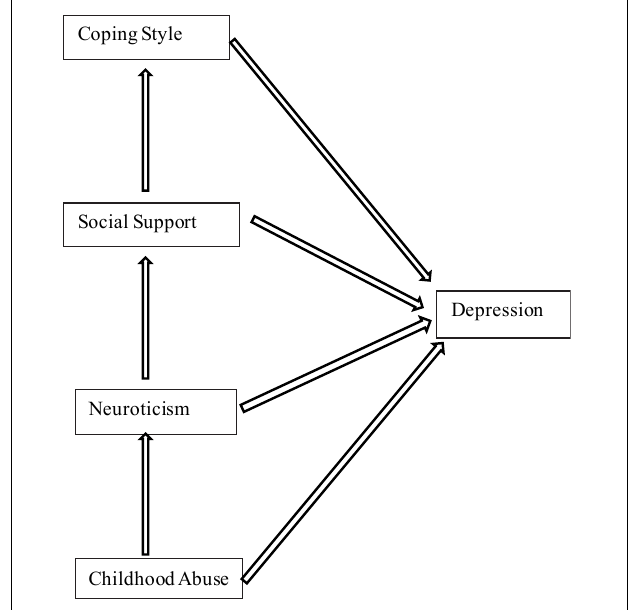
FIGURE 1 | The hypothesis. SEM of the hypothesis of this study. In this model, childhood abuse, neuroticism, social support, and coping style predict depressive